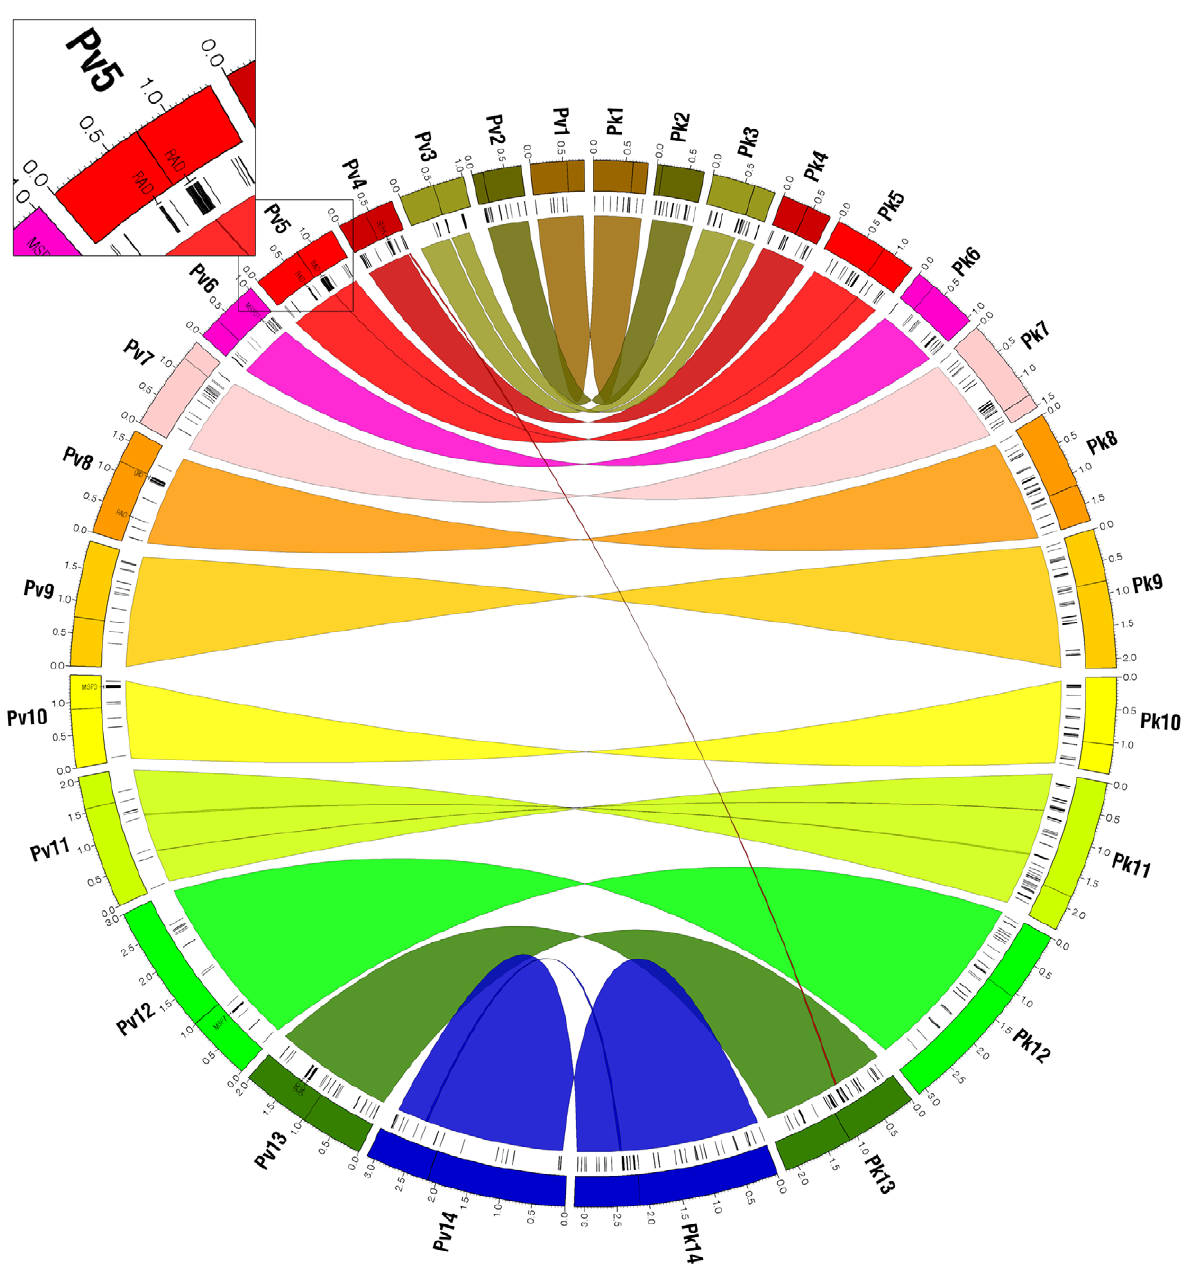
Figure 5. P.vivax and P.knowlesi share almost perfect 1-to-1 chromosomal synteny but also harbor hundreds of putative parasite- specific genes in chromosome-internal regions. Outer segments depict the 14 nuclear chromosomes of P. vivax (left semicircle, counter- clockwise) and P. knowlesi (right semicircle, clockwise). Ribbons represent the 20 identified imperfect synteny blocks (both nested and non-nested) colored according to connected P. vivax chromosomes. Black tick marks underneath chromosomes indicate putative P. vivax -specific genes (281) and P. knowlesi -specific genes (364) located at SGRs and SBRs. Parasite-specific genes in subtelomeric regions (STRs) not shown. Text labels within chromosomes indicate parasite-specific genes mentioned in the text. The inset shows the largest identified SGR in P. vivax containing 26 RAD genes. Black lines within chromosomes indicate putative centromeres. Excluding subtelomeres, imperfect synteny blocks span complete chromosomes with only two exceptions ( P. vivax chromosomes 3 and 4), but also contain many putative parasite-specific genes, particularly in P. knowlesi . Image created with Circos [56].